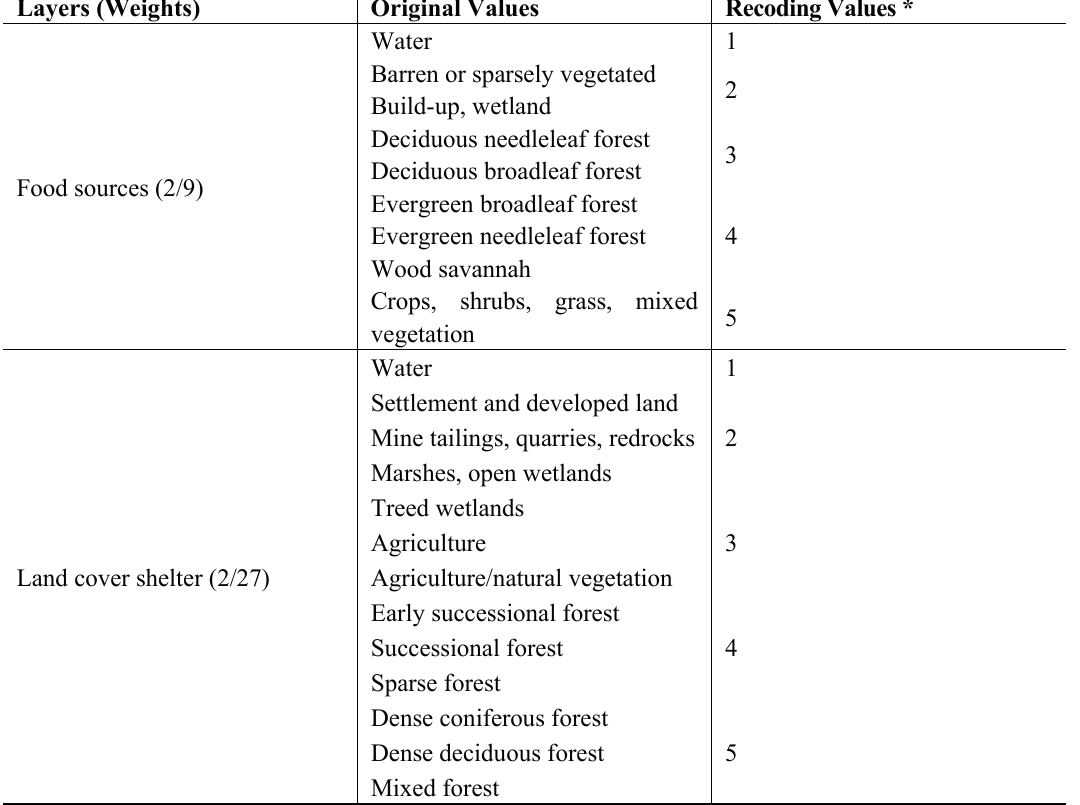
Table A1. The recoding schemes and weights used for different layers in the MCDM